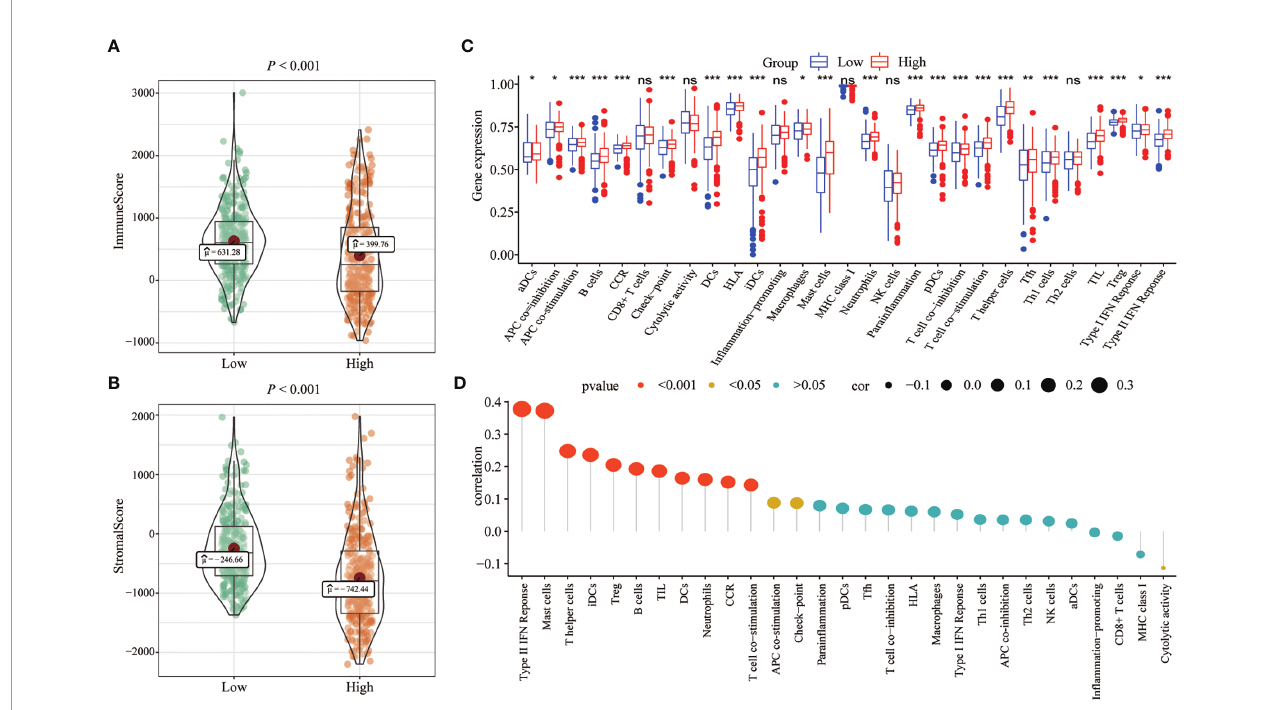
FIGURE 5 | Correlation between fetal-lethal non-coding developmental regulatory RNA (FENDRR) expression and immune cell in fi ltration. (A, B) Association of high FENDRR with immune scores and stromal scores ( p < 0.001). (C) Association of high and low FENDRR expression with the proportions of multiple subtypes of immune cells. (D) Lollipop chart of FENDRR expression and different immune cell subtypes. Circle sizes represent the magnitude of the correlation coef fi cients. Colors represent the signi fi cance level (i.e., p -values). *, **, ***, indicate signi fi cance at p < 0.05, p < 0.01 and p < 0.001, respectively. ns, indicates no statistical signi fi